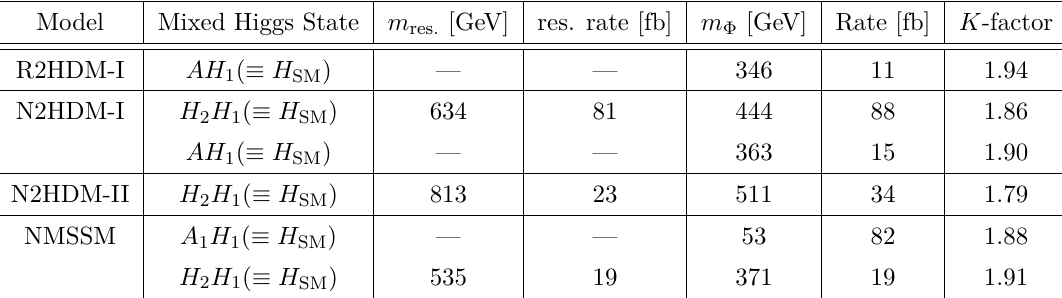
¯ Table 30 . Maximum rates at NLO QCD in the ( b b )( t ¯ t ) final state at NLO for different mixed Higgs pair final states in the investigated models with the non-SM-like Higgs decaying into t ¯ t ; the corresponding K -factor is given in the last column. In case of resonantly enhanced production, we give in the third and fourth column, respectively, the mass of the resonant Higgs boson and the resonant cross section as defined in the text. The fifth column contains the mass of the non-SM-like final state Higgs boson. More details on these points can be provided on